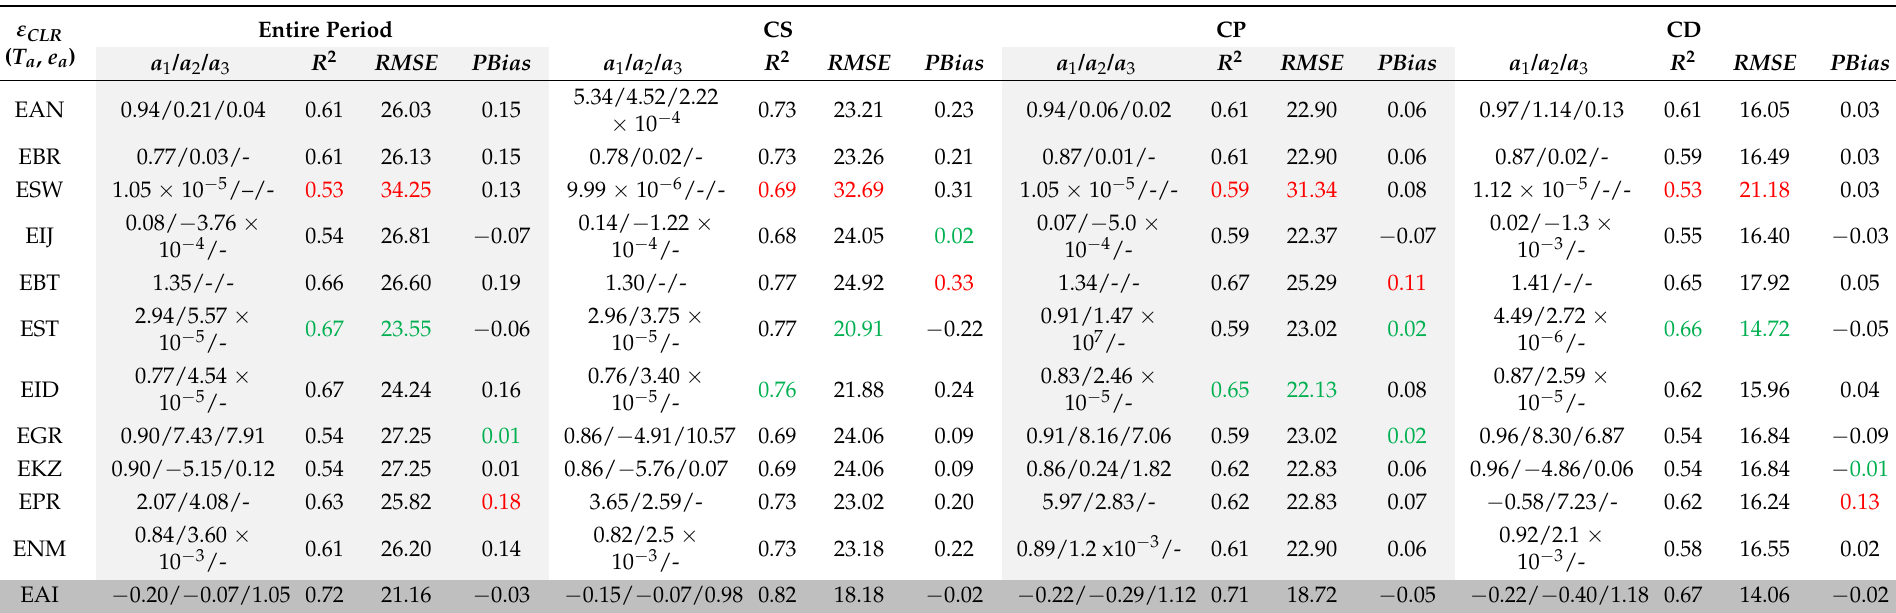
Table 4. Calibrated coefficients and statistical index for the entire period and different sky coverage classifications for Step 2. The best results are colored in green and the worst in red. RMSE in (Wm − 2 ) and PBias in